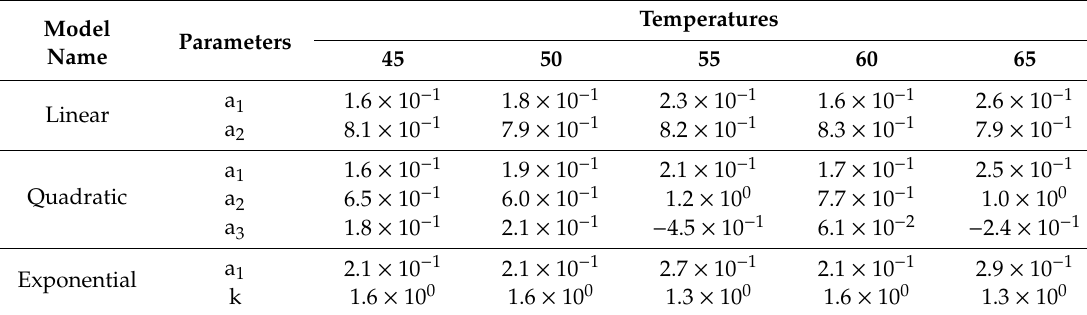
Table 7. Model parameters (k, the shrinkage constant; a 1 , a 2 , a 3 , the shrinkage coe ffi cients) of the shrinkage